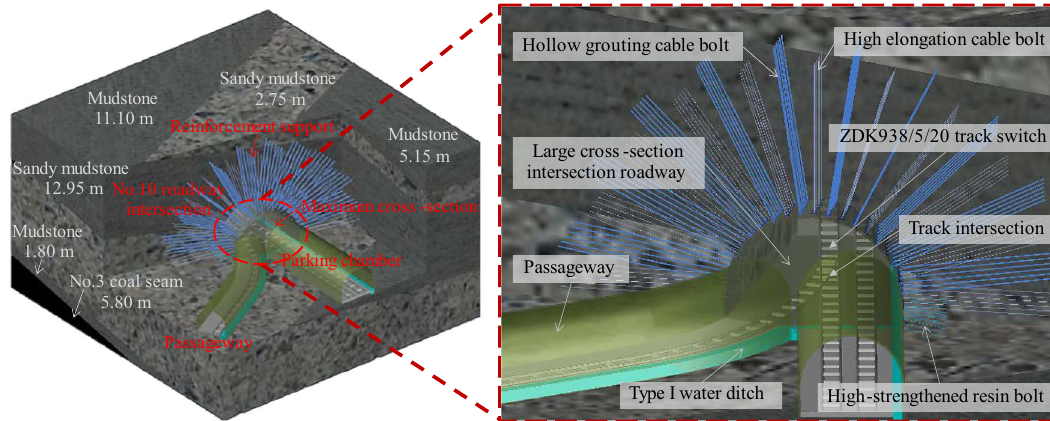
Fig. 26 Effect of strengthening support on